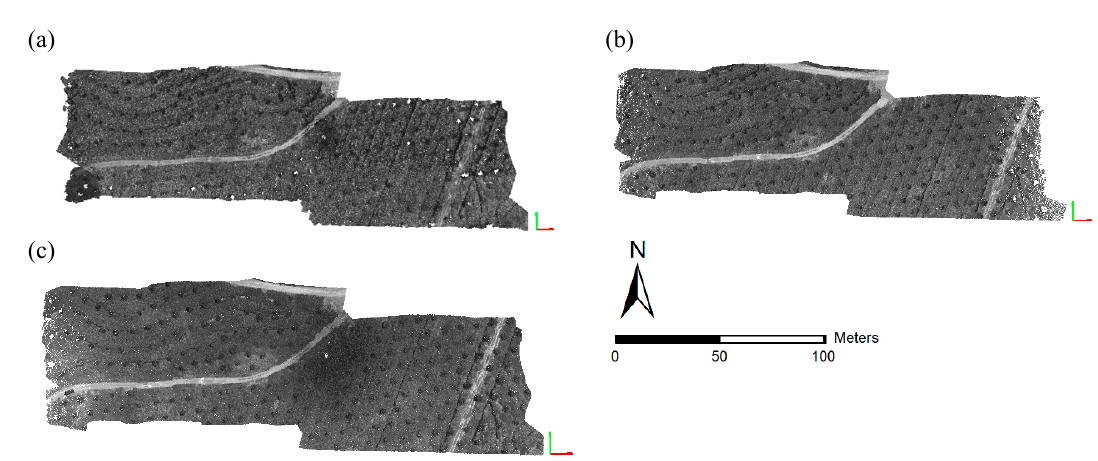
Figure A1. Point Clouds of the AOI at UAV altitude of ( a ) 20 m, ( b ) 60 m and ( c ) 80 m.